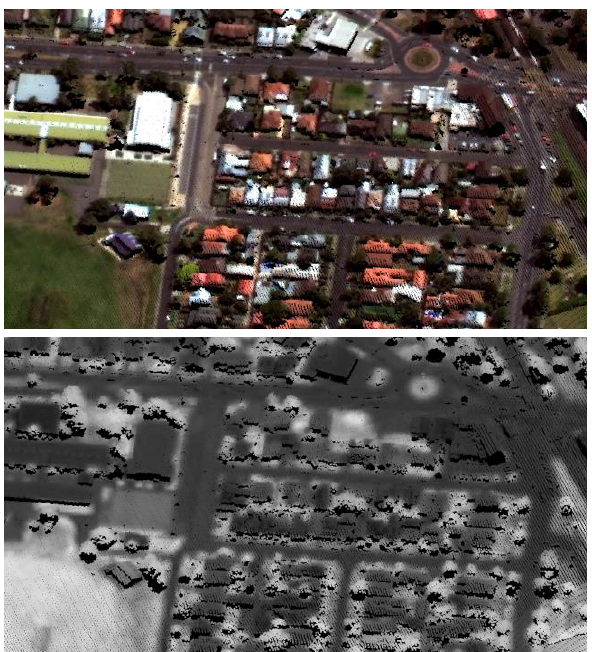
Figure 5. Colourised LiDAR points with colour (top) and NDVI images (bottom) for a small